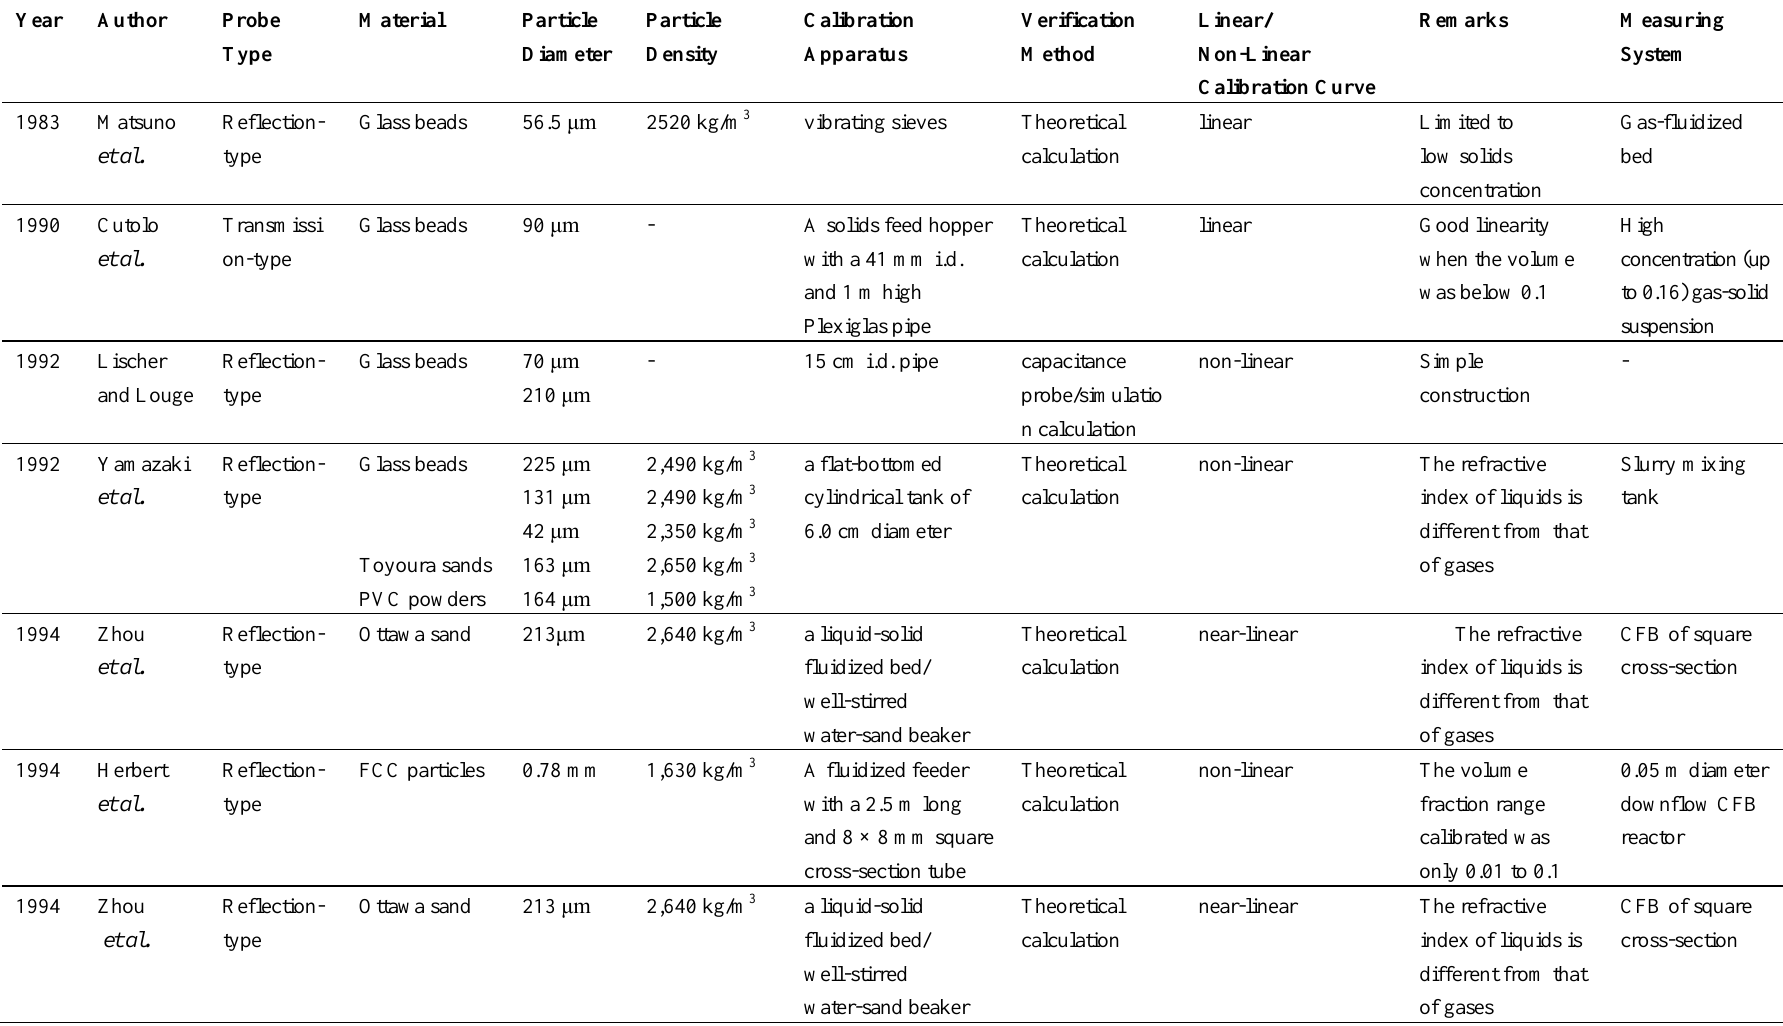
Table 1. Different calibration